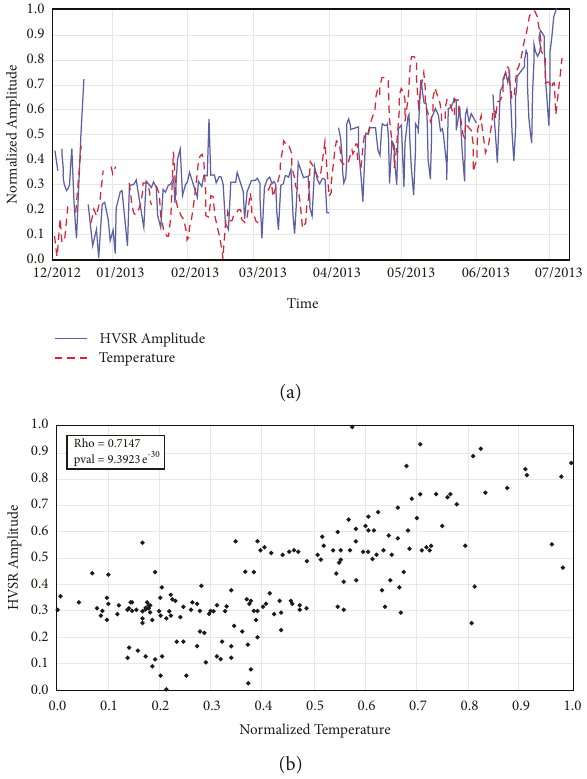
Figure 10: (a) HVSR peak amplitude at TOR4 and temperature. (b) Correlation between the HVSR TOR4 peak amplitude and the normalized